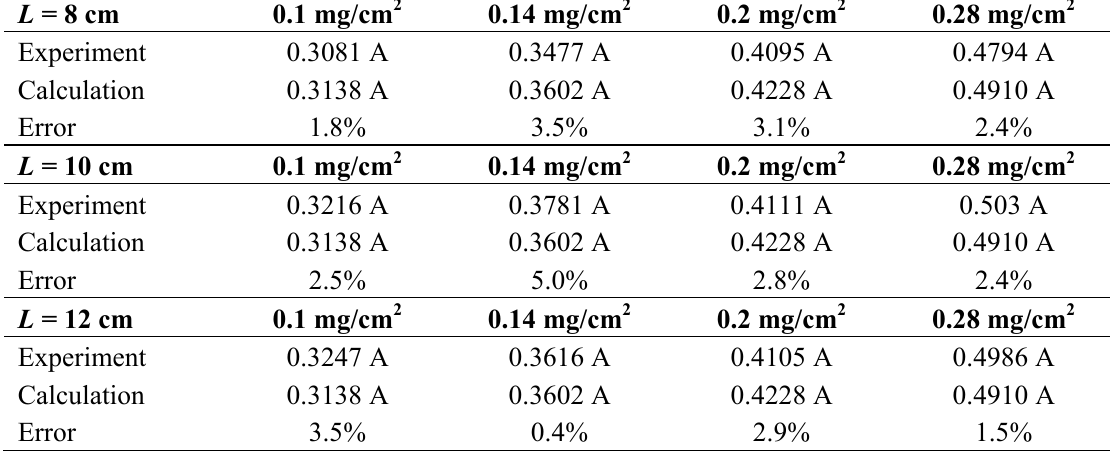
Table 2. The comparison of the critical current between proposed model and experiment.